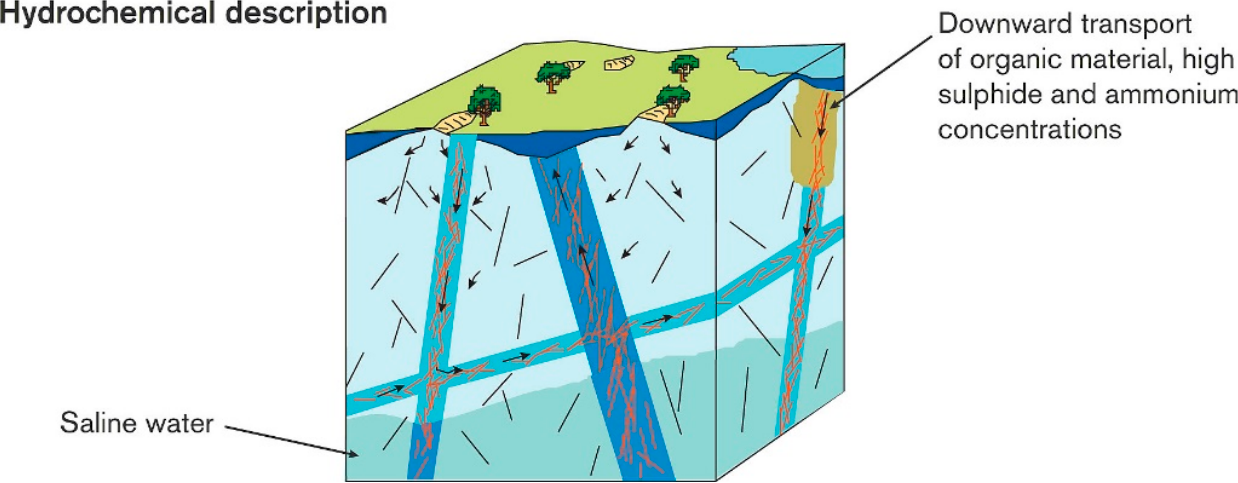
Figure 2. Schematic visualization of major groundwater types used in the hydrogeochemical description. Groundwater compositions depend on mixing and reaction processes along different recharge pathways through a crystalline rock environment consisting of deformation zones and background rock [16]. The arrows indicate the groundwater flow direction.